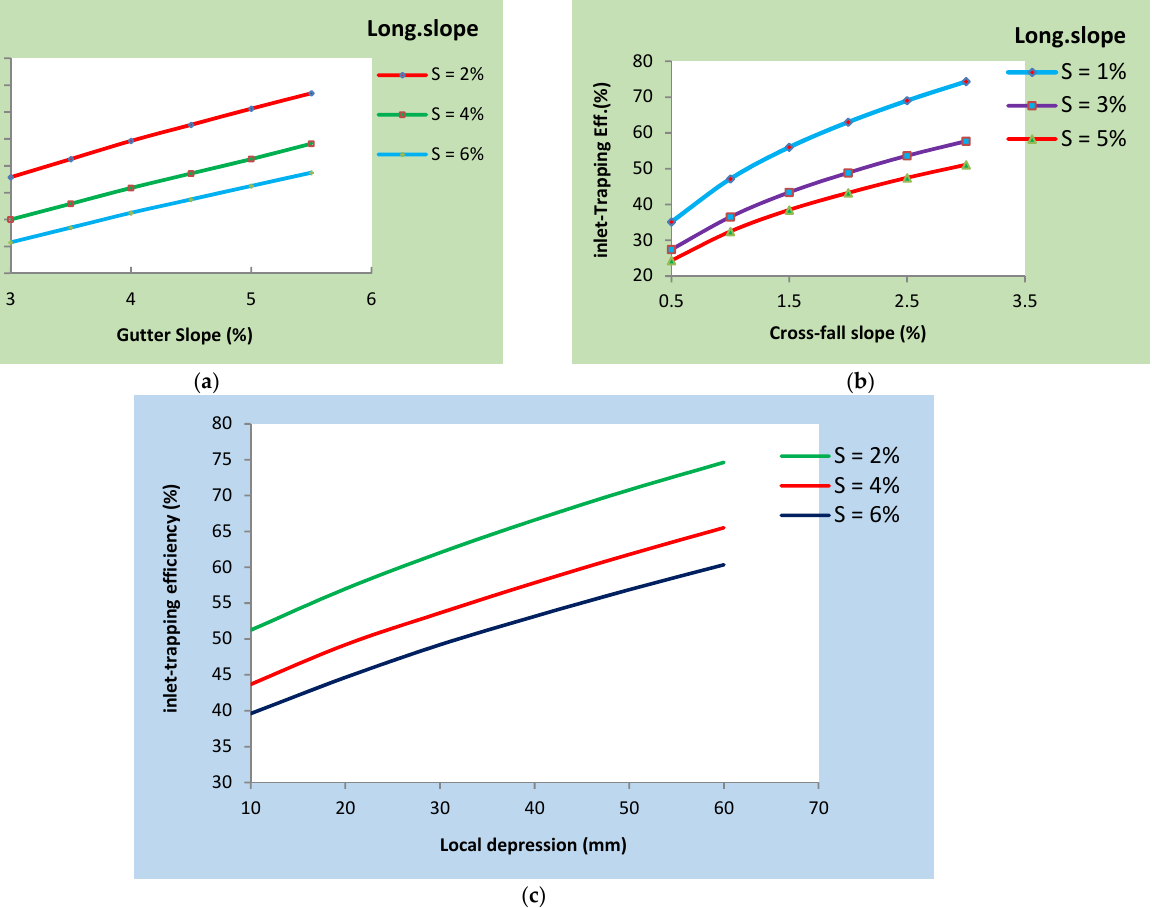
Figure 13. Longitudinal drainage inlet-trapping efficiency based on various parameters of: gutter slope ( a ), cross-fall slope ( b ), and local depression ( c ).